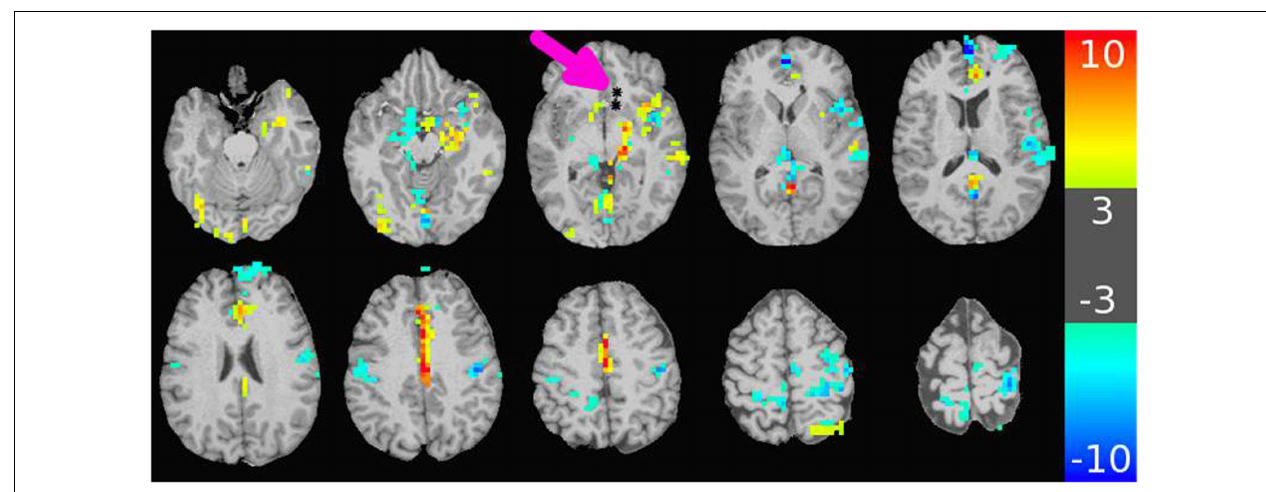
activation along known anatomic features such as the left cingulate gyrus; and strong negative activation as seen in the bilateral sensorimotor regions.The stimulation used a 32s block design with an alternating unipolar 8mA pulse at 20Hz.TheTR was 2s, over four blocks for a 5min acquisition.The patient was under general anesthesia (3).